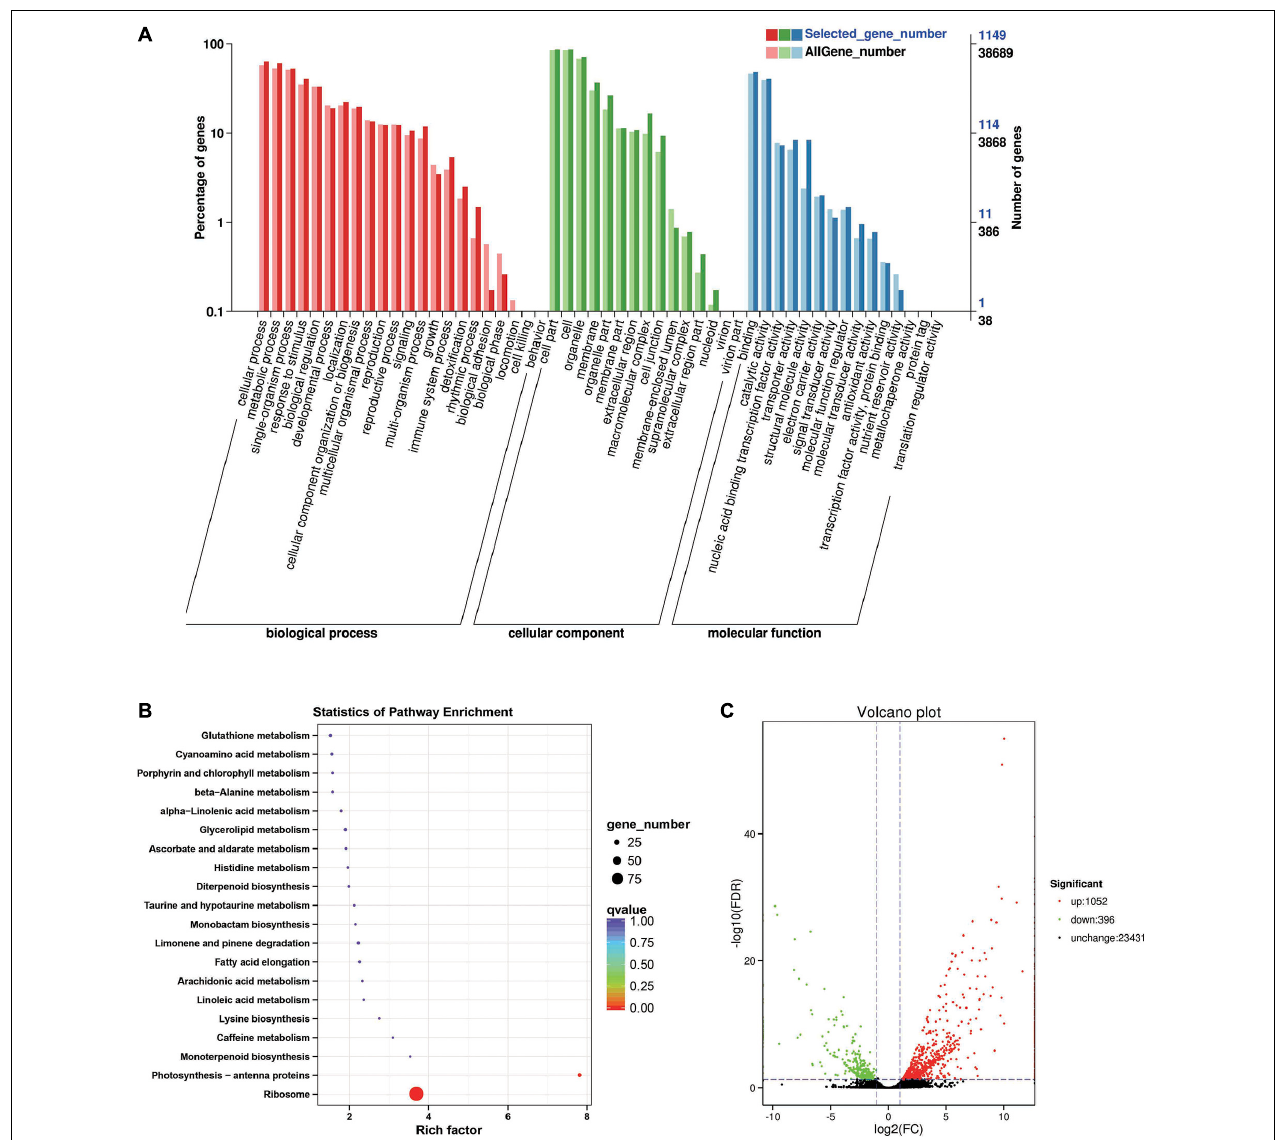
FIGURE 5 | Enrichment analysis of differentially expressed genes between C3 and C1 groups. (A) GO classification statistics of differentially expressed genes. It mainly includes three branches: biological process, cellular component, and molecular function. (B) KEGG pathway enrichment statistics of differentially expressed genes. (C) Volcano plot statistics of the number of differentially expressed genes. C1: BcL.1-25 , C3: BcL.2-25